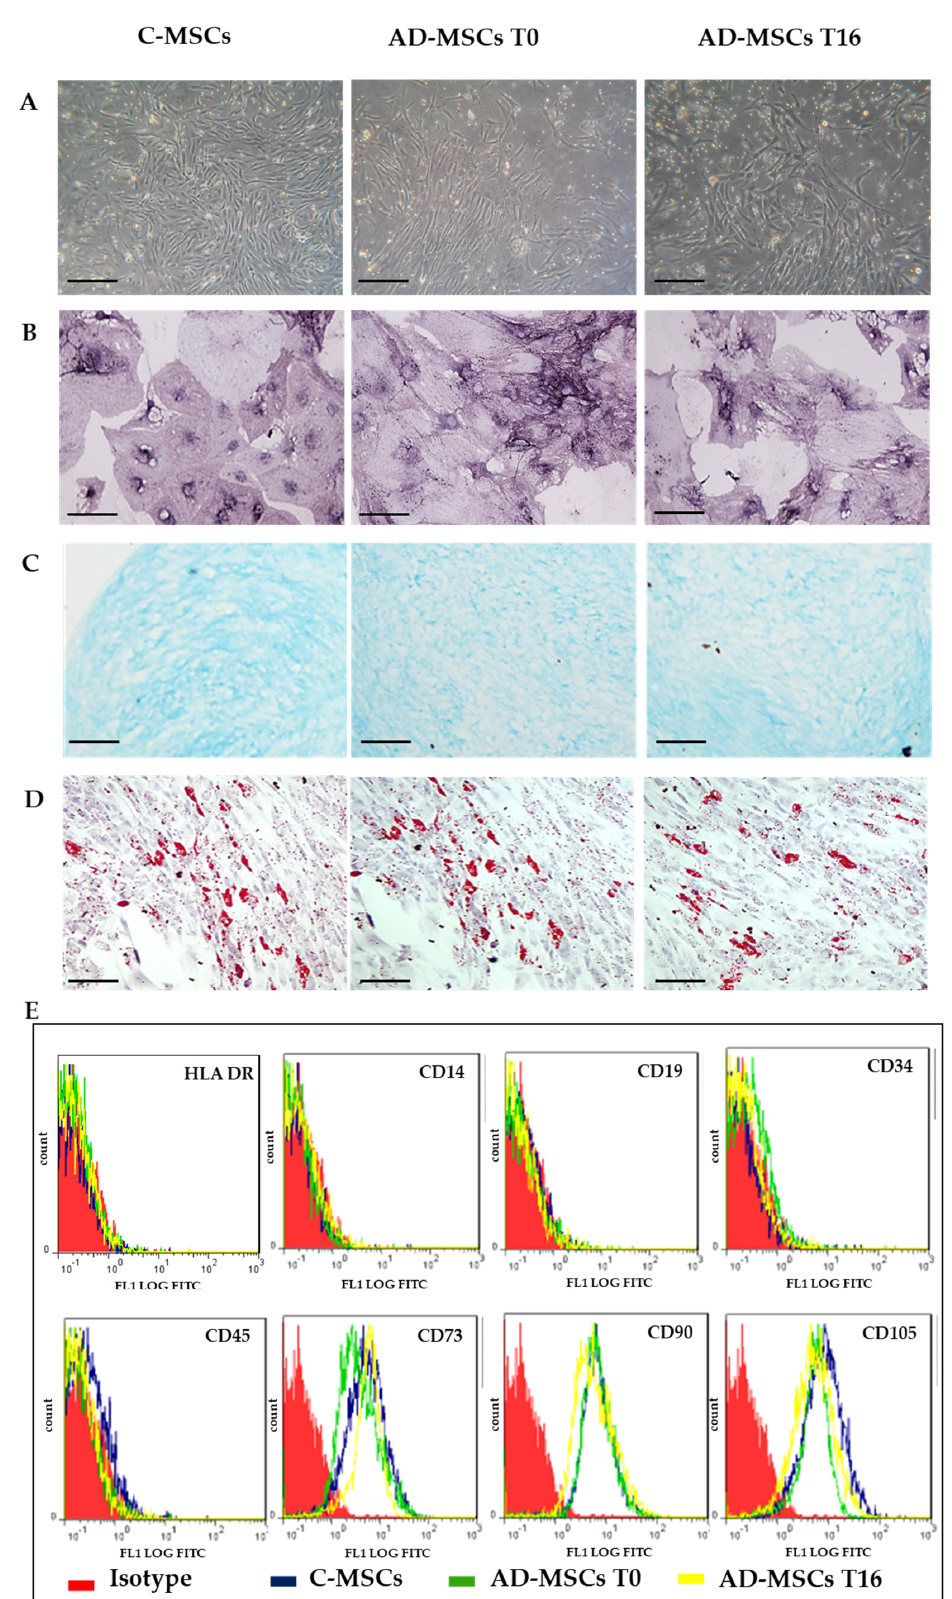
Figure 1. Representative images for Mesenchymal Stem Cells (MSCs) characterization. ( A ) Phase- contrast images of MSCs derived from skin of healthy control subject (C-MSC) and of patients